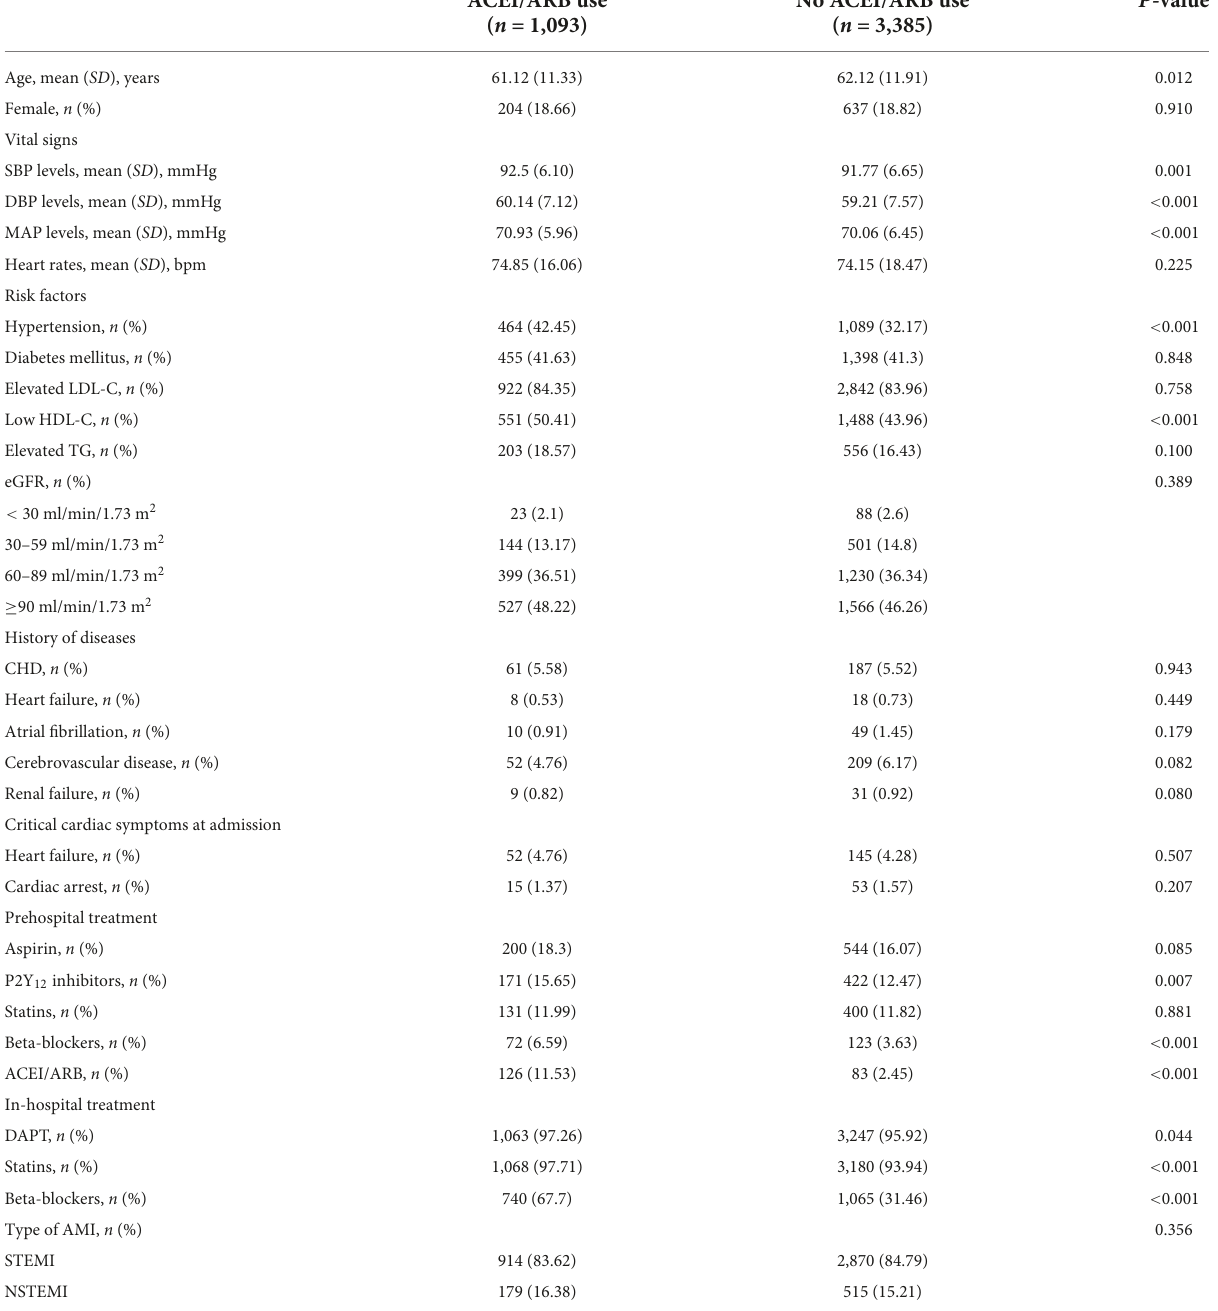
TABLE 1 Comparison of characteristics and in-hospital treatment between patients with and without early ACEI/ARB